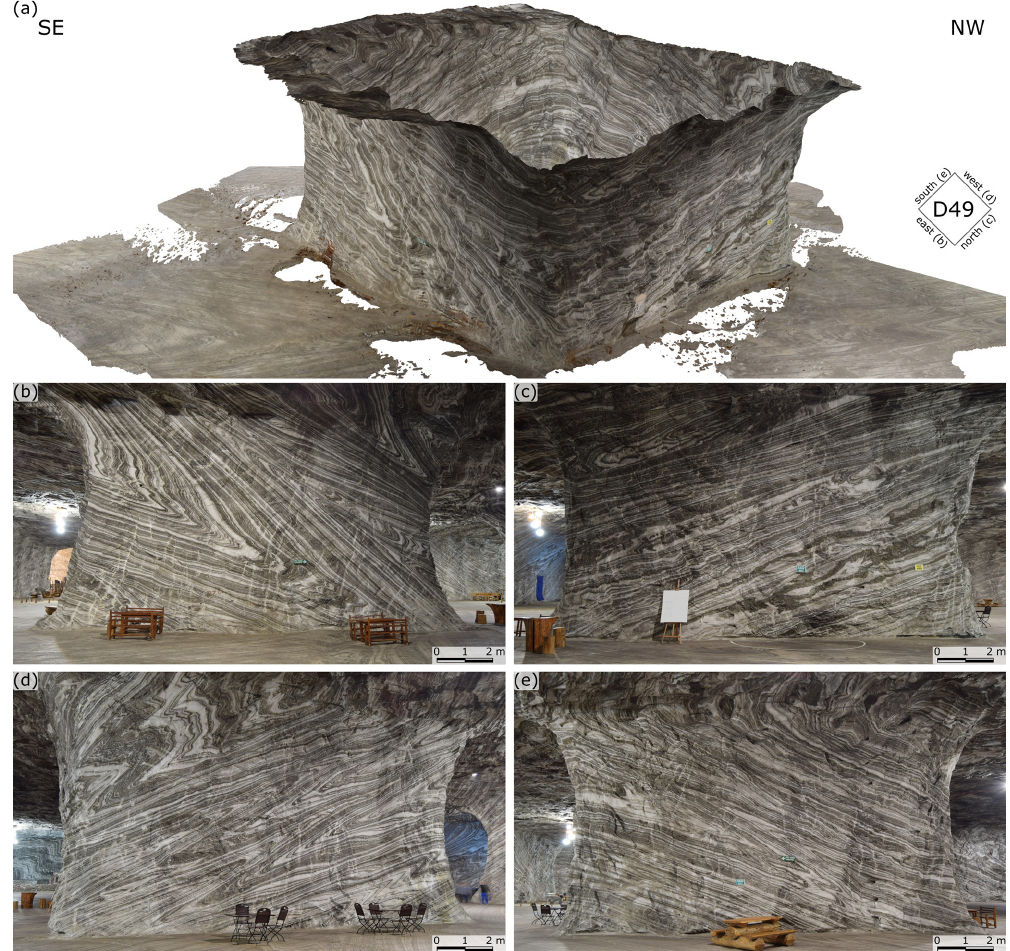
Figure 3. (a) 3D digital model of pillar D49. (b) Photograph of the east-facing pillar wall. (c) Photograph of the north-facing pillar wall. (d) Photograph of the west-facing pillar wall. (e) Photograph of the south-facing pillar